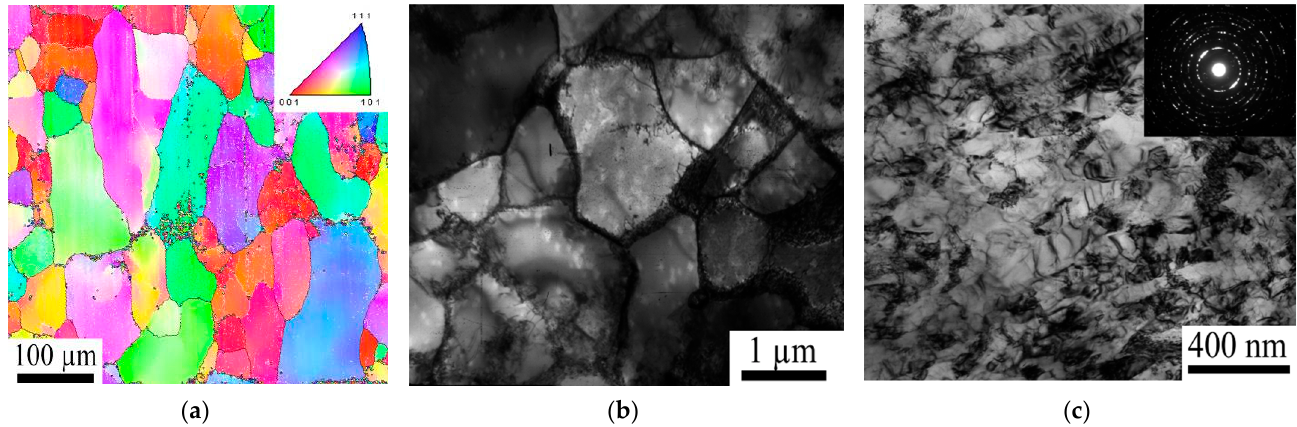
Figure 9. Microstructure of ARMCO iron after LSP and fatigue test: ( a ) EBSD IPF map and ( b , c ) TEM images; ( b ) the image was obtained in the center of the specimen and ( c ) at the surface layer and selected area diffraction pattern. The bottom edge of the EBSD map corresponds to the surface of the specimen.